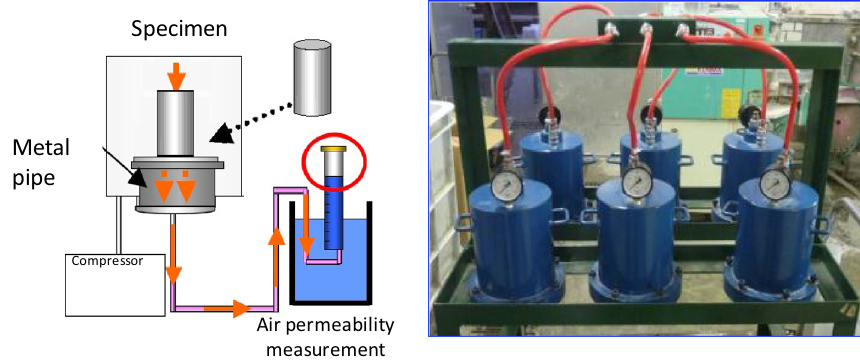
Fig. 1 Air permeability test setup.